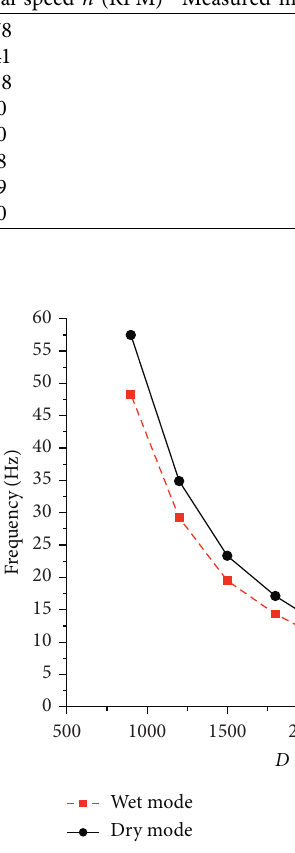
Figure 11: Natural frequencies for the dry and wet